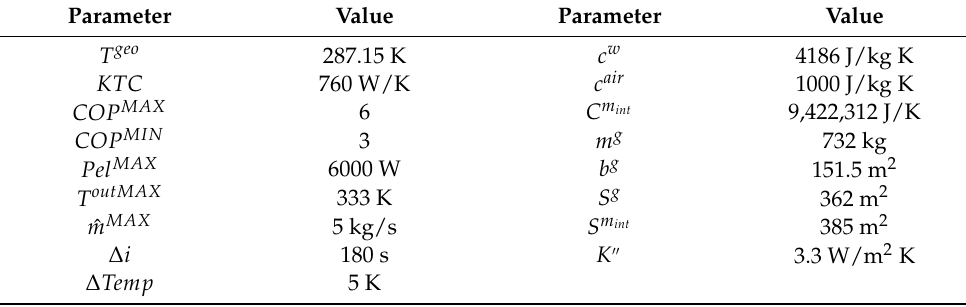
Table 1. Parameters of the